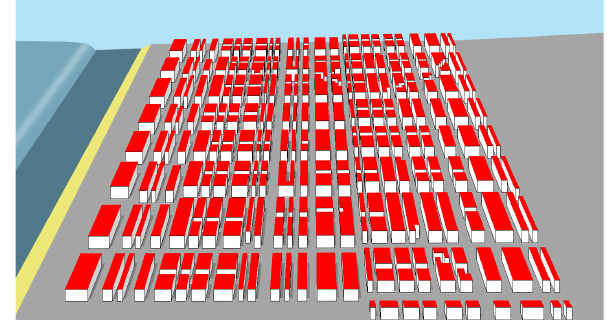
Fig. 3. 3-D view of the artificial “roughness city”, consisting of stable houses and streets.